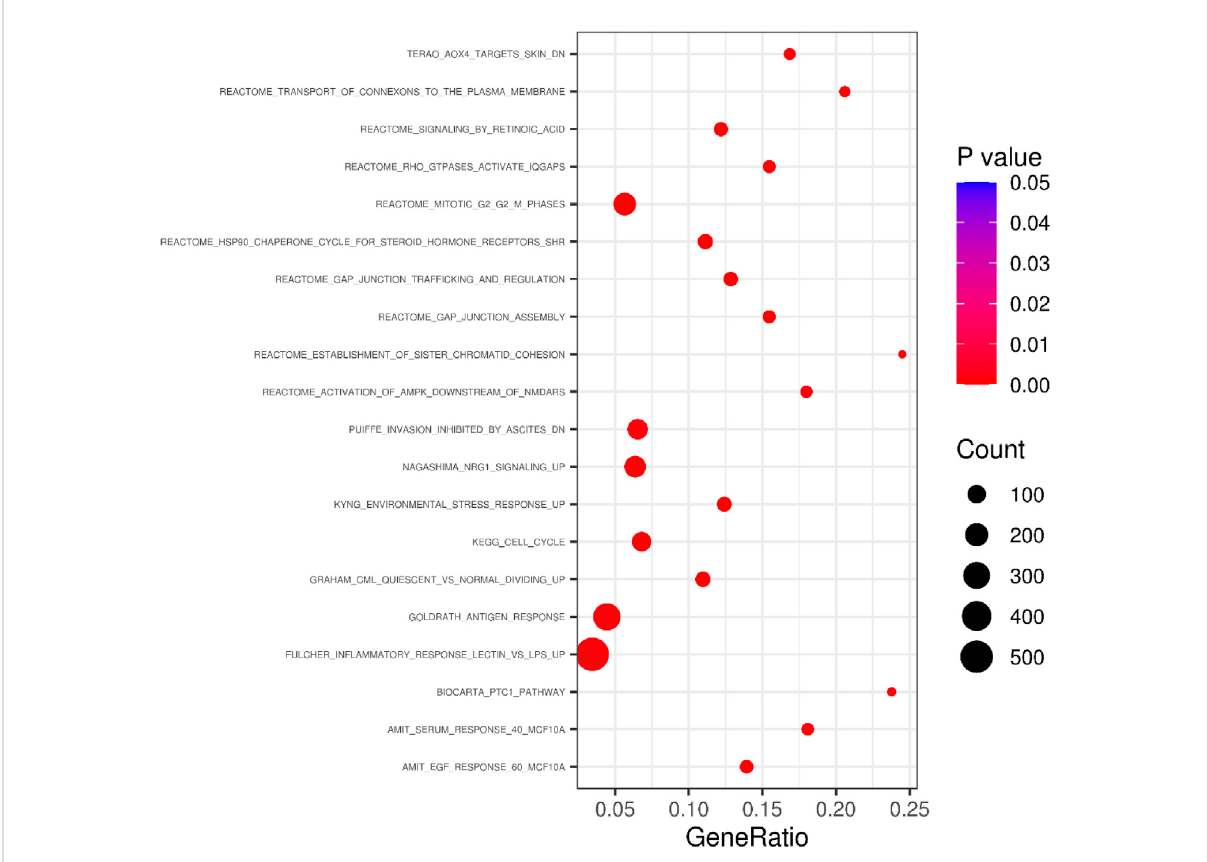
FIGURE 8 Bubble plot summarising the results of the pathway-based enrichment tests for DSWM. The plot reveals 20 pathways with the lowest p